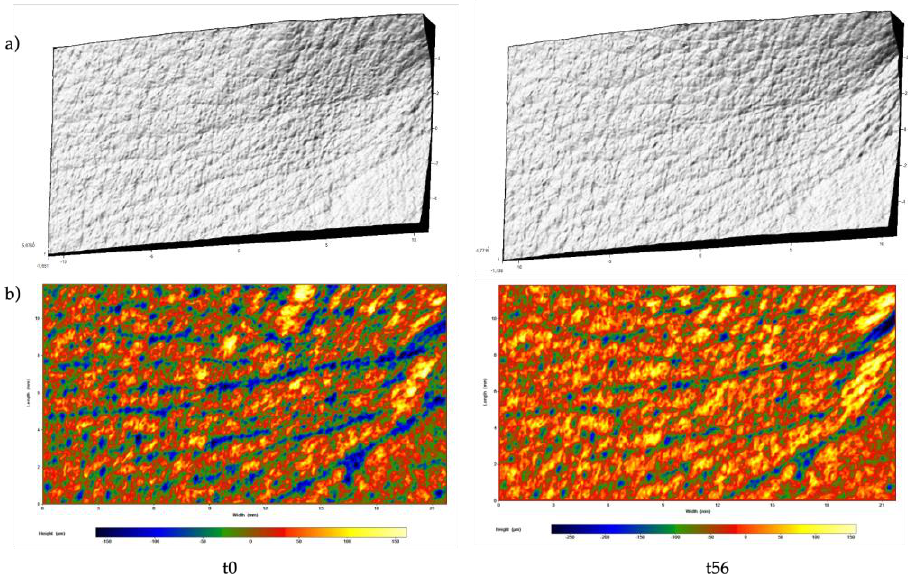
Figure 1. Shown is a 3D picture of wrinkles in the eye contour, obtained with PRIMOS Premium equipment from one of the volunteers before (t0) and after 56 (t56) consecutive days of application of the active formulation, twice daily. ( a ) Photography; ( b ) Representation of the relief in a colored image, where the blue color represents the deepest areas, and depth decreases moving from green to red, orange, and yellow (the highest areas).